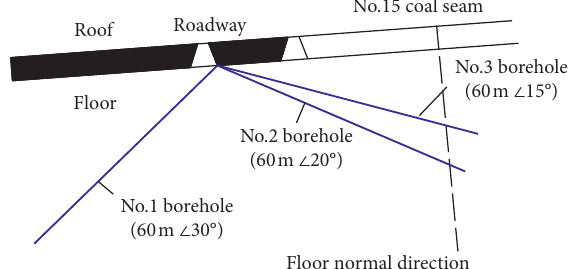
Figure 10: The layout of the drilling